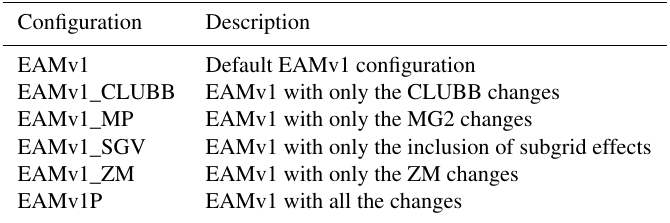
Table 6. Global mean 10-year-averaged cloud properties of EAMv1, EAMv1_CLUBB, EAMv1_MP, EAMv1_SGV, EAMv1_ZM, EAMv1P, and satellite observations summarized in Stubenrauch et al. (2013) and Neubauer et al. (2019). Relevant cloud properties listed here are TOA shortwave cloud radiative effects (SWCRE; unit = Wm − 2 ) and those of liquid clouds (SWCRE liq ), ice clouds (SWCRE ice ), snow (SWCRE snow ), and convective clouds (SWCRE conv ); TOA longwave cloud radiative effects (LWCRE; unit = Wm − 2 ) and those of liquid clouds (LWCRE liq ), ice clouds (LWCRE ice ), snow (LWCRE snow ), and convective clouds (LWCRE conv ); cloud fraction (unit = %) of the total column ( F cld , tot ), below 700hPa ( F cld , low ), between 400 and 700hPa ( F cld , med ), and above 400hPa ( F cld , hgh ); optical depth of all clouds ( τ cld ) and that of liquid clouds ( τ liq ), ice clouds ( τ ice ), snow ( τ snow ), convective clouds ( τ conv ), and all clouds below 700hPa ( τ low ) and above 400hPa ( τ hgh ); column-integrated total LWP (unit = gm − 2 ) and IWP (unit = gm − 2 ), N c (unit = 10 9 m − 2 ) and N i (unit = 10 9 m − 2 ); altitude of the top ( Z hgh , top ; unit = km) and base ( Z hgh , top ; unit = km) of clouds above 400hPa; and altitude of the top ( Z low , top ; unit = km) and base ( Z low , top ; unit = km) of clouds below 700hPa.